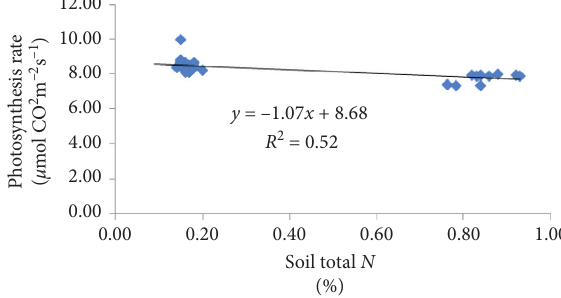
Figure 4: Relationship between pepper photosynthetic rate and soil total N in a pepper farm grown with mature